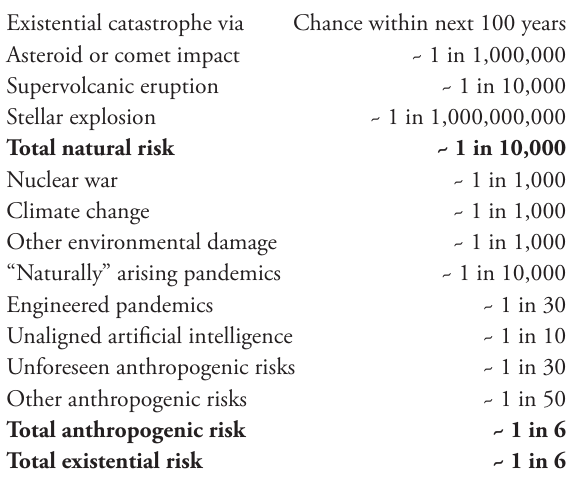
Table 1: Estimates for the chances of an existential catastrophe curtailing humanity’s potential Existential catastrophe